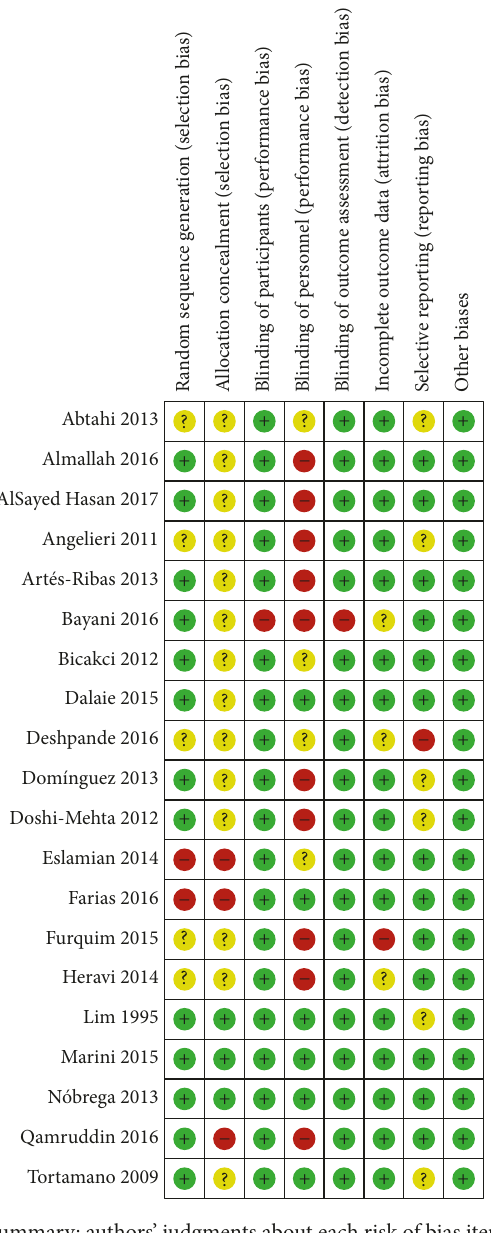
Figure 2: Risk of bias summary: authors’ judgments about each risk of bias item for studies